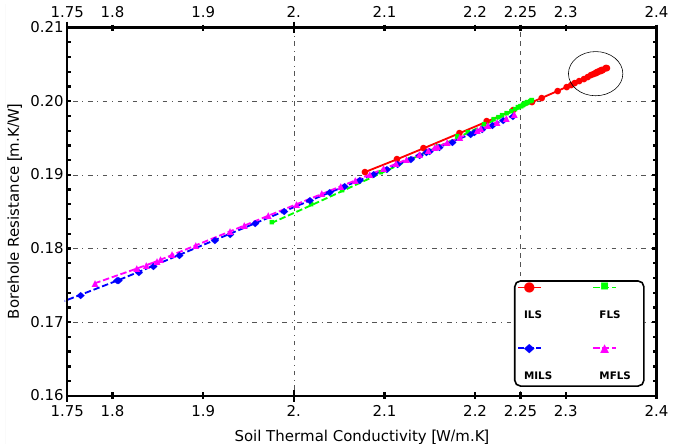
Figure 4. Trajectories of the successive ( λ , R b ) estimates in the corresponding parameter plane. The circle represents the parameter region around which the parameter estimates accumulate for a longer test